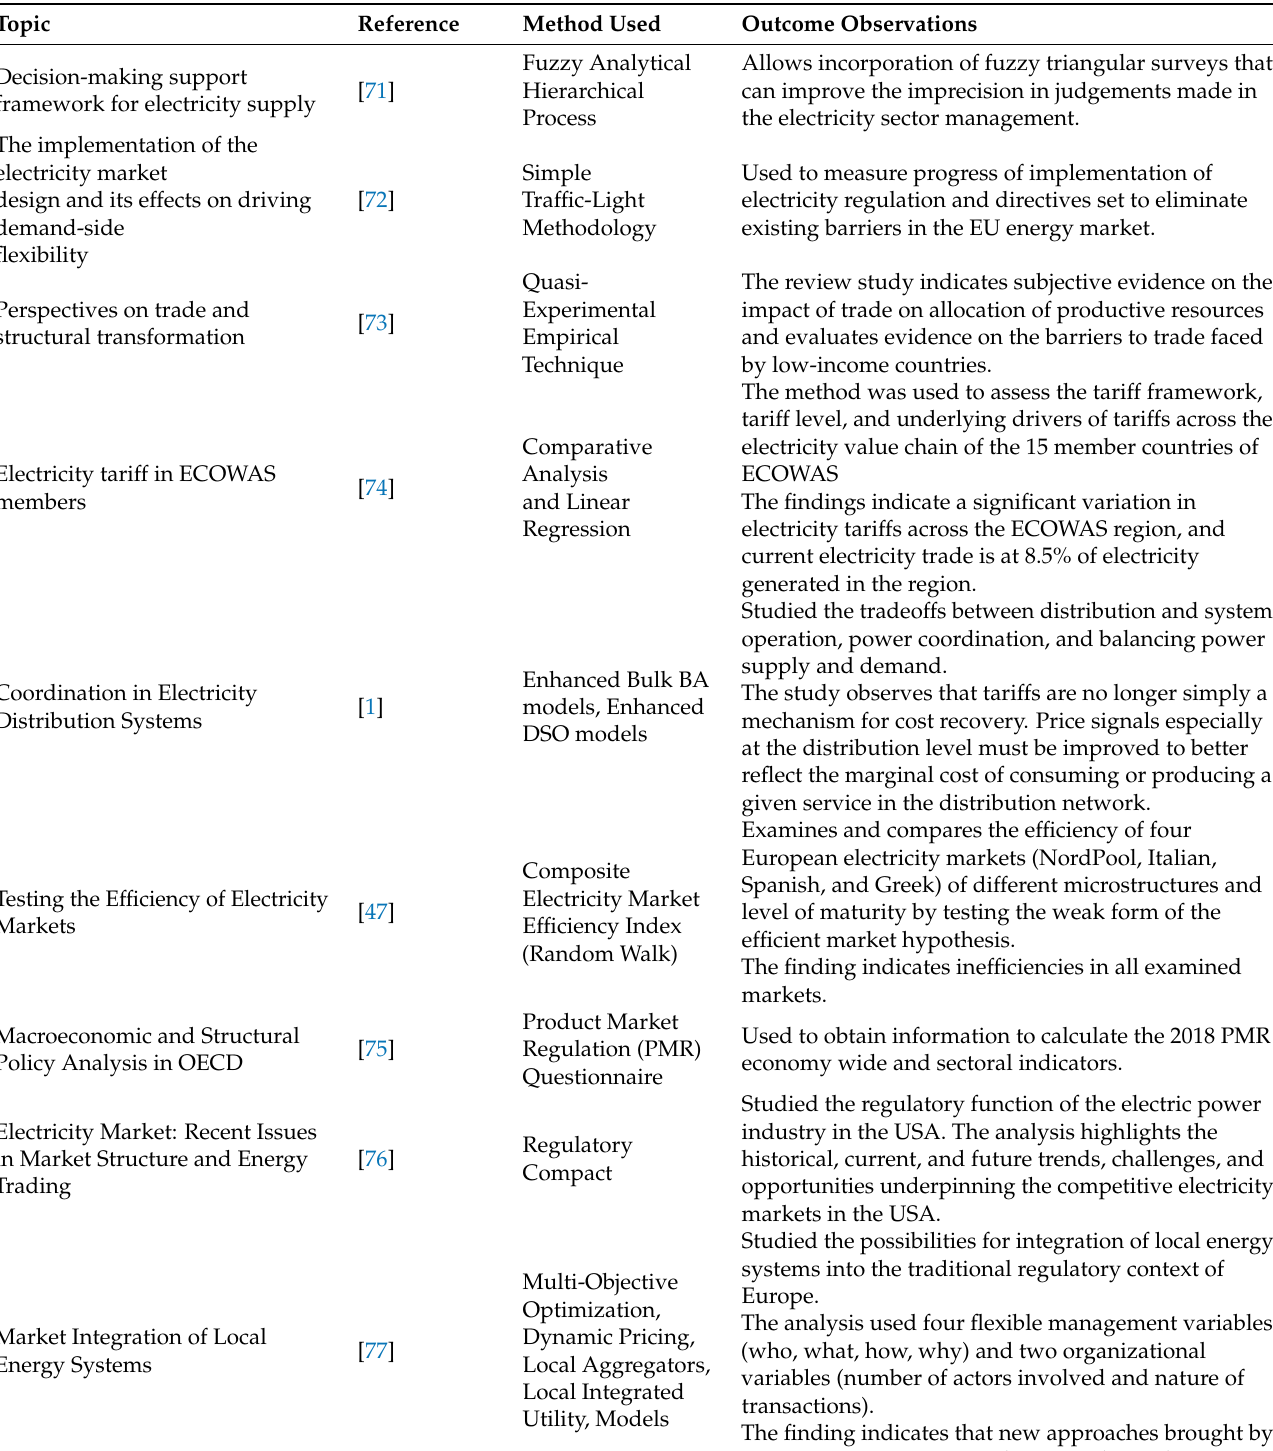
Table 11. A short review of methods used by studies on market